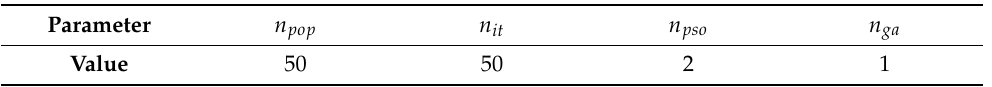
Table 5. Simulation parameters for the PSO-GA algorithm in different scenarios.